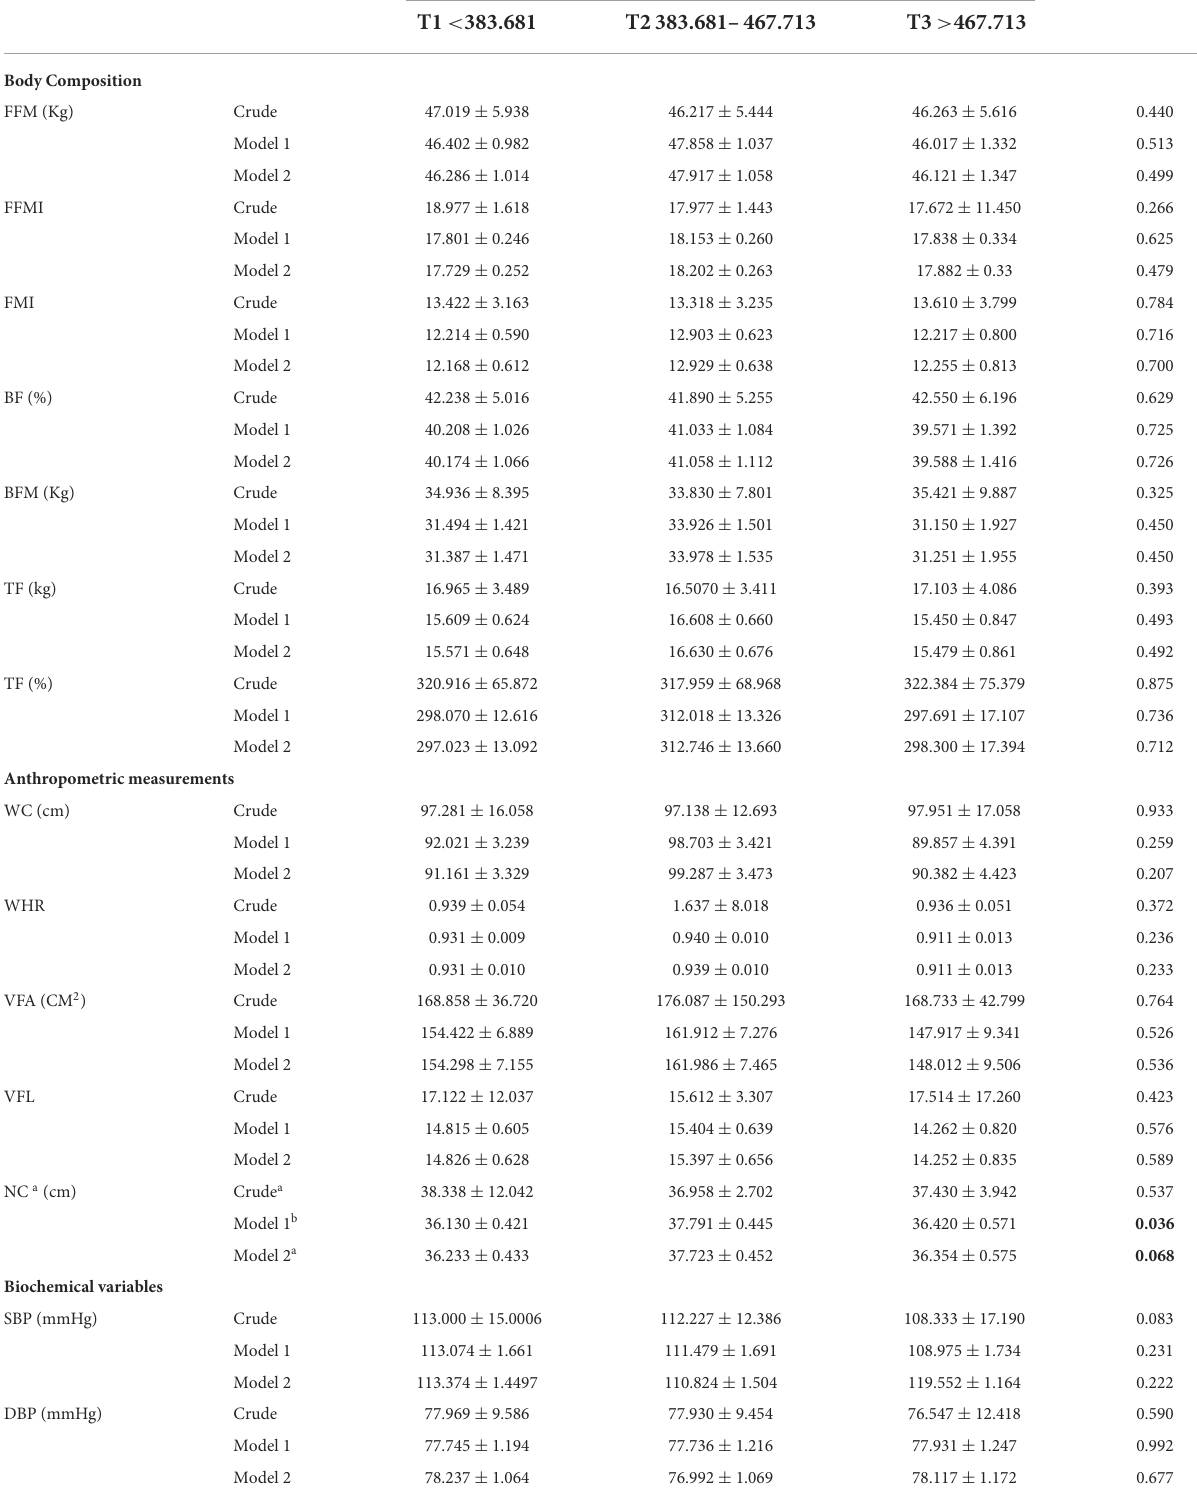
TABLE 3 CVD risk factors consist of anthropometric measurements and body composition, biochemical variables, and inflammatory factors among tertiles of NOVA score in obese and overweight women ( n =